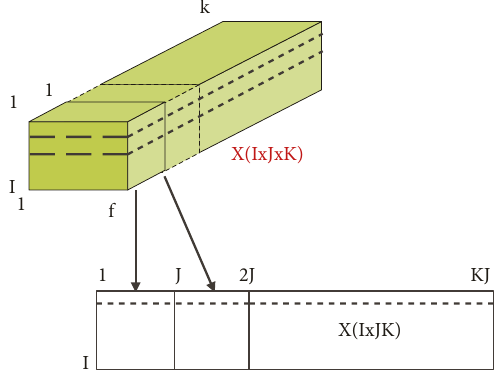
Figure 3: Schematic diagram of a batch expansion of 3D data.